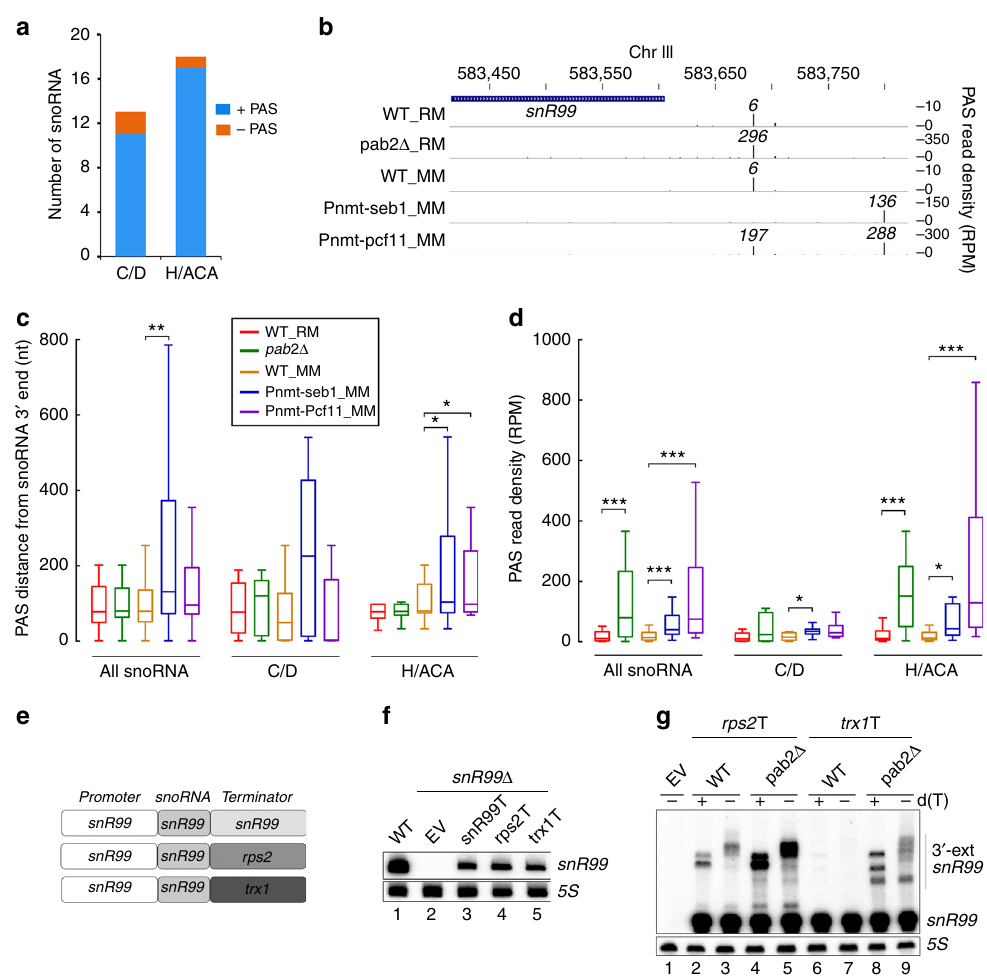
Fig. 3 Independently transcribed snoRNA genes are cleaved and polyadenylated. a Proportion of 13 C/D box and 18 H/ACA box monocistronic snoRNAs with at least one poly(A) site mapped by 3 ′ READS in the WT strain grown in minimal or rich media. b Poly(A) site (PAS) read density (in RPM) pro fi le downstream of the snR99 snoRNA as determined by 3 ′ READS in the indicated strains grown in either rich (RM) or minimal (MM) media supplemented with thiamine for 15 h to deplete Seb1 and Pcf11. c , d Box plots showing the distribution of the distance calculated between the strongest poly(A) site (PAS) and the annotated snoRNA 3 ′ end ( c ), as well as the sum of the read density for all of the poly(A) sites associated to a snoRNA in each condition ( d ). Center lines correspond to the median and the signi fi cance of difference (Wilcoxon signed-rank test) is indicated for comparing groups ( ∗ p < 0.05; ∗∗ p < 0.01; ∗∗∗ p < 0.005). e Schematic of snR99 constructs with different 3 ′ fl anking sequences used for experiments in f and g . f Northern blot analysis of